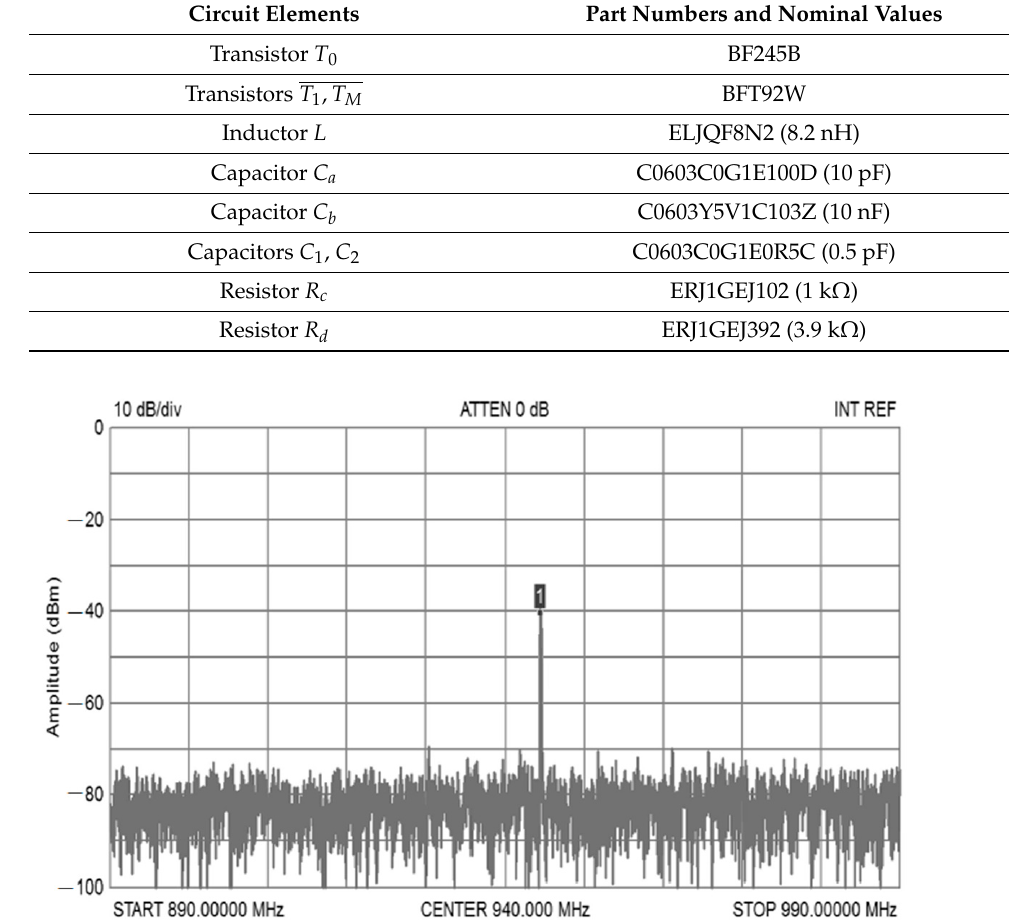
Table 16. Circuit elements used in the oscillator with MIWCM assembled on a printed circuit board.